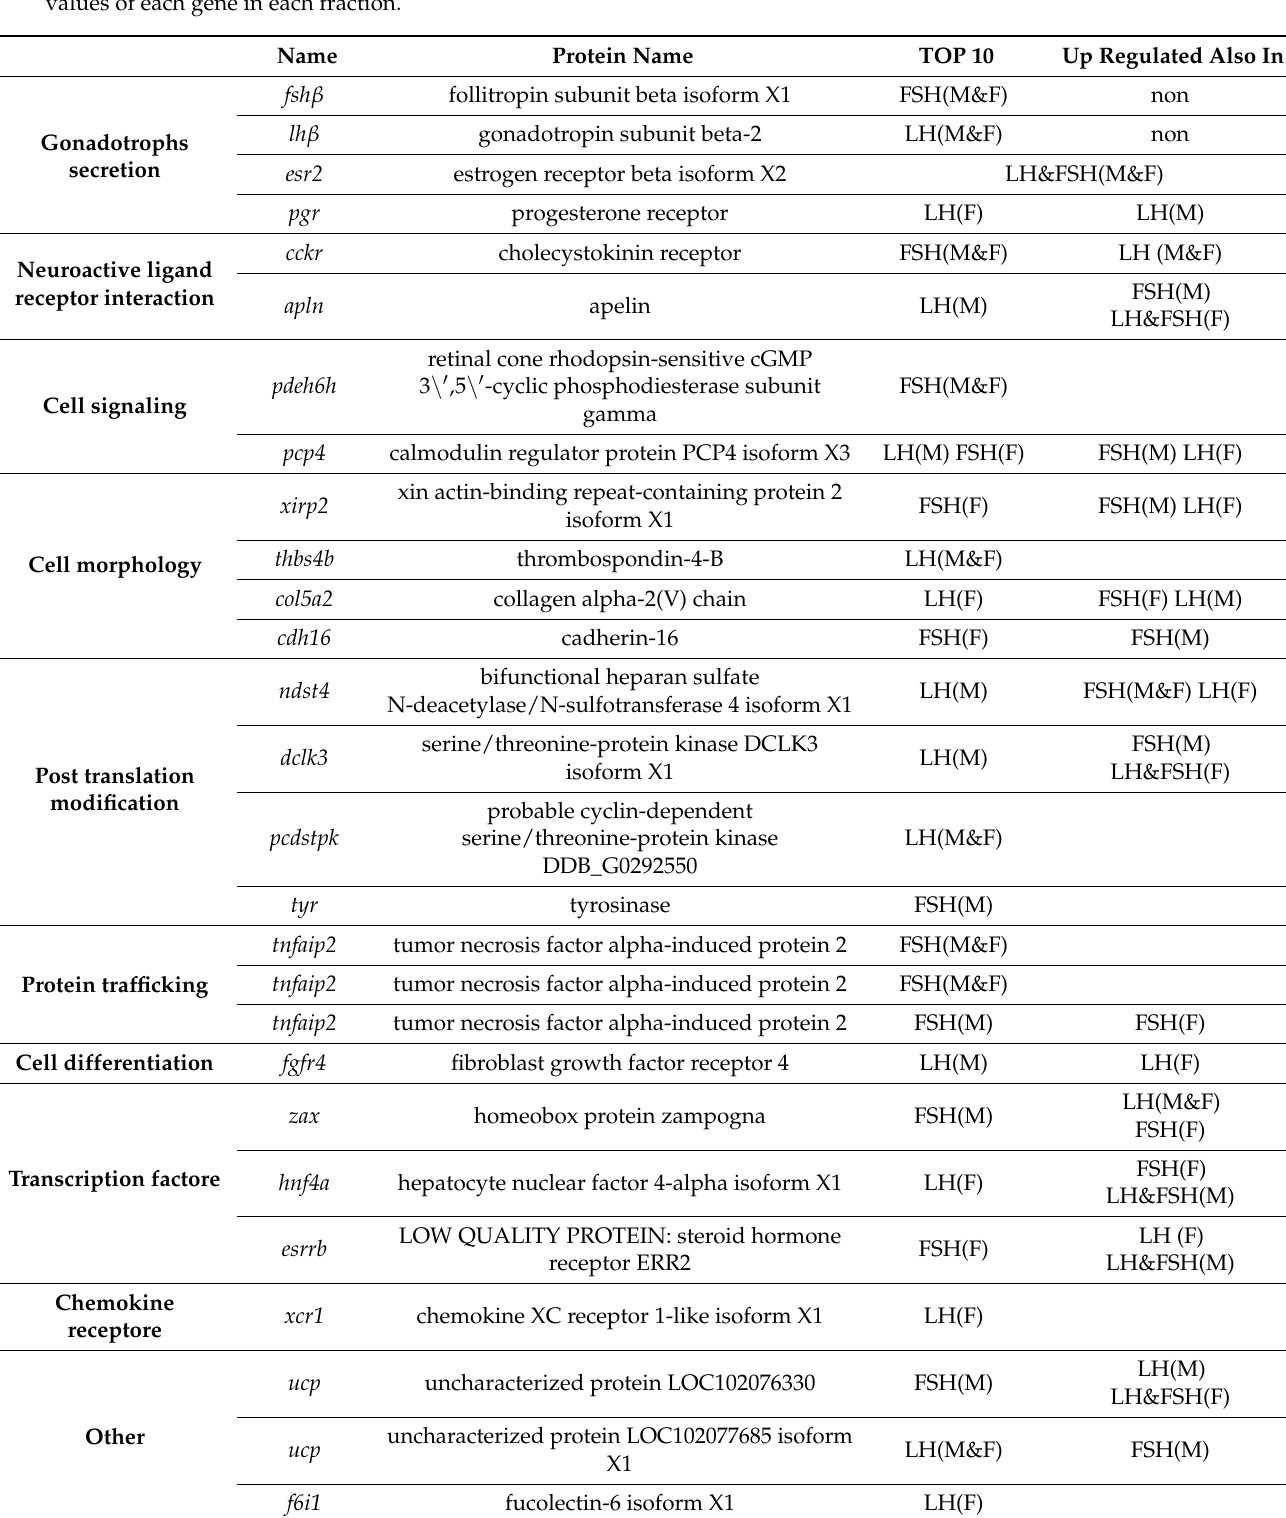
Table 1. Top 10 upregulated genes according to fold change in FACS sorted cells. Genes were grouped according to suggested function classification. Each gene is one of the top 10 genes in one or more of the different FACS samples as mentioned in the “TOP 10” column. Some of the genes are also enriched in additional samples but not included in their top 10 genes as mentioned in the “upregulated also in” column. See Supplementary Table S3 for fold change and expression values of each gene in each